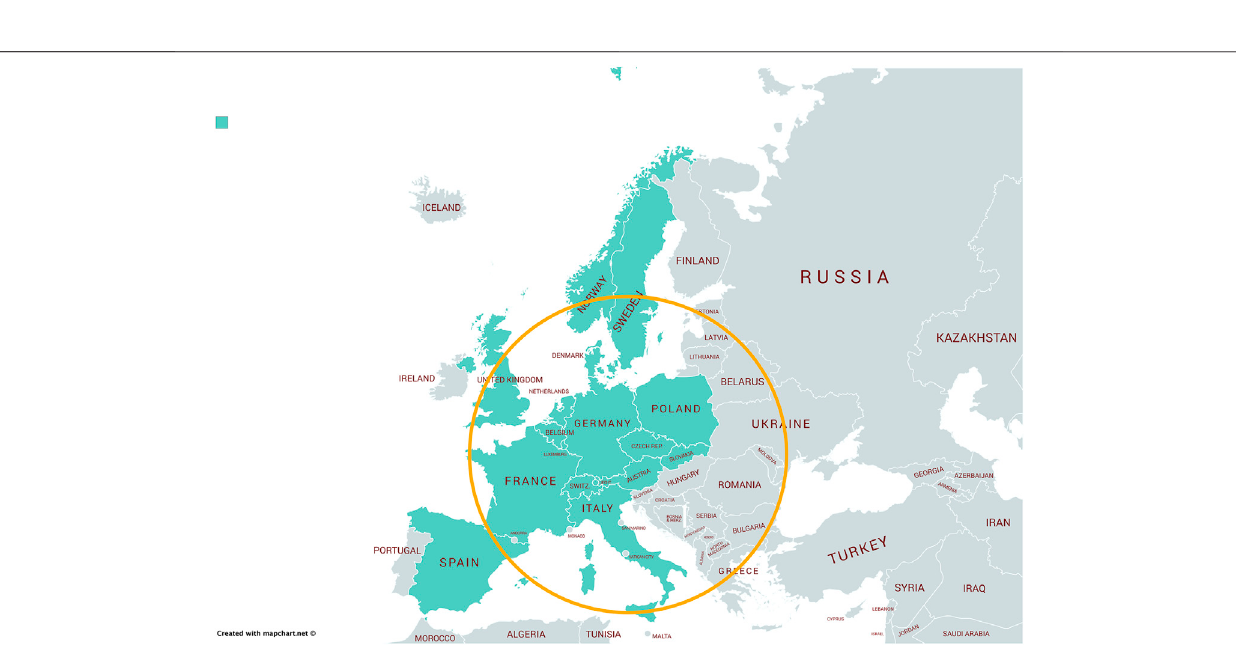
FIGURE 3 | PT centers in Europe, none in SEE region with around 40 million